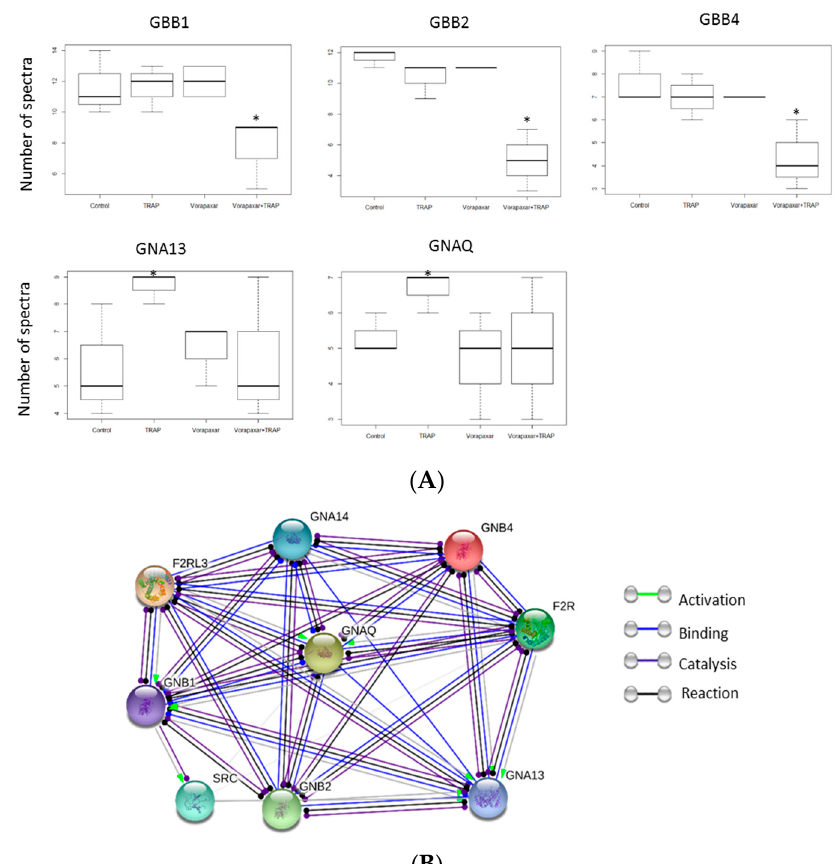
Figure 6. Thrombin signaling through proteinase-activated receptor participating proteins. ( A ) Proteins which showed significant difference in number of spectra in experimental groups. * p < 0.05 according to one-way ANOVA test. ( B ) Network analysis of proteins detected in thrombin signaling through proteinase-activated receptors. GBB: guanine nucleotide-binding protein GI/GS/GT subunit beta; GNA: guanine nucleotide-binding protein subunit alpha; GNAQ: guanine nucleotide-binding protein G(q) subunit alpha; GNB: guanine nucleotide-binding protein subunit beta; Src: proto-oncogene tyrosine-protein kinase; PAR: protease activated receptor; F2R (PAR1): coagulation factor II thrombin receptor; F2RL3 (PAR4): F2R like trypsin receptor